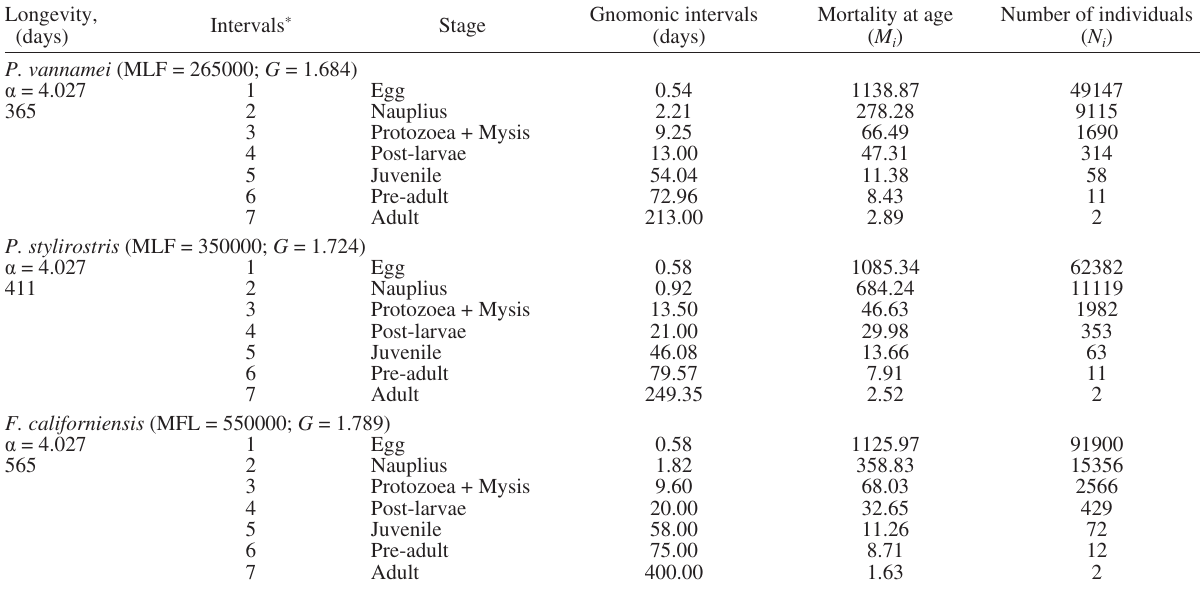
Table 5. – Estimation of the natural mortality for the gnomonic intervals ( M ) using the mean duration of the first life stage (egg stage) for the i species of white ( L. vannamei ), blue ( L. stylirostris ), and brown ( F. californiensis ) shrimps, using the gnomonic model; MLF, mean lifetime fecundity ; G , constant probability of death for each interval; α , is a proportionality constant. Longevity, (days)